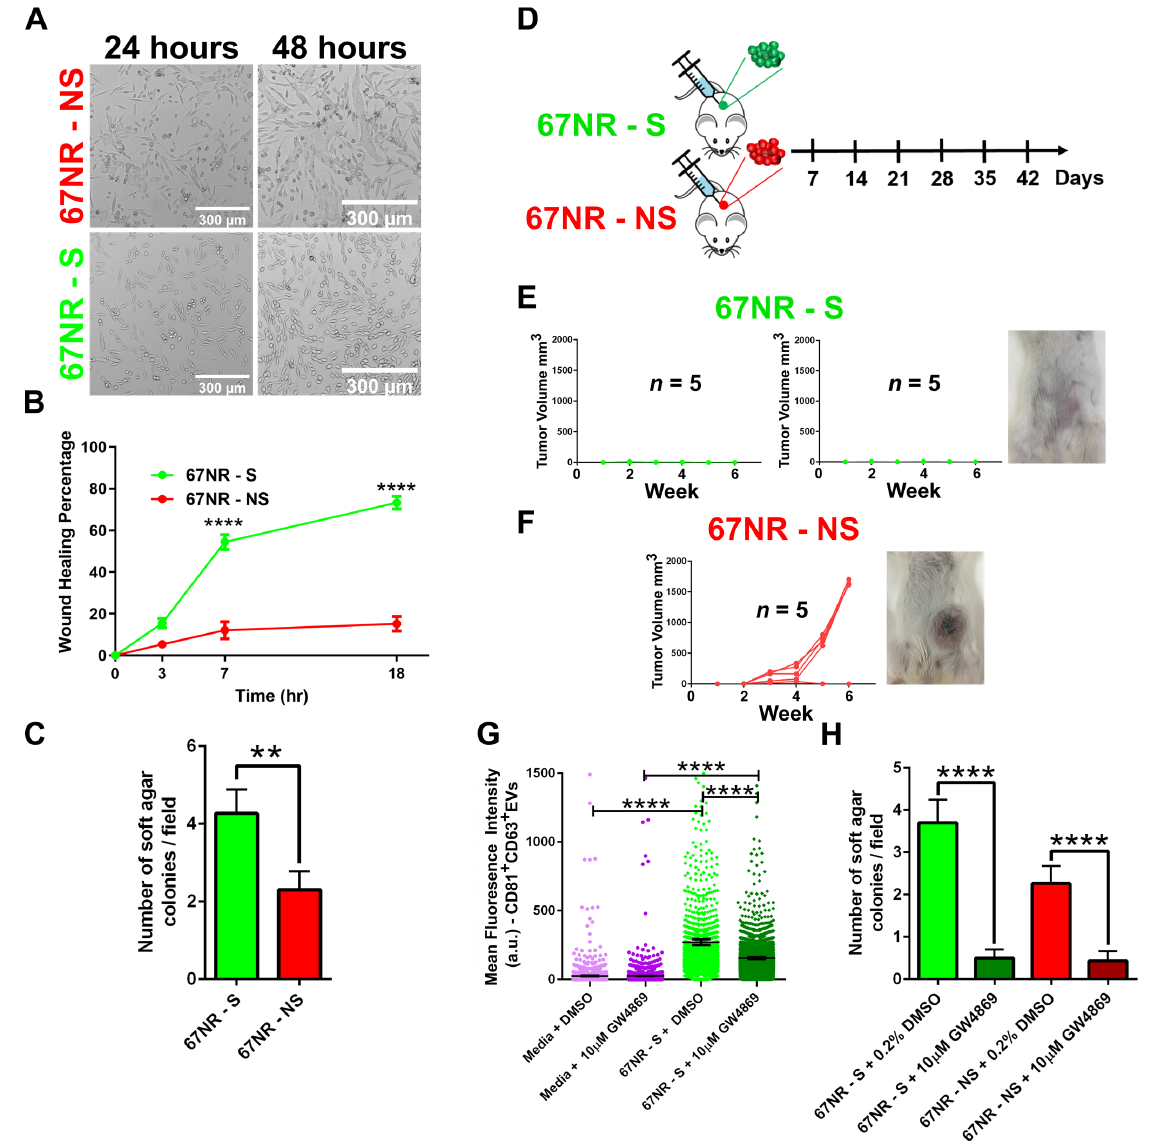
Figure 4. Assessing the functionality of 67NR-NS and 67NR-S cells. ( A ) The morphology of 67NR-NS and 67NR-S cell populations recorded using phase-contrast microscopy. ( B ) Wound healing assays illustrating the migration of 67NR-S and 67-NR-NS clonal cell populations (mean ± SEM, n = 6 for each cell line). Two-way ANOVA was used for comparison; **** p < 0.0001. ( C ) 67NR-S cell populations have a higher capacity to form colonies in comparison with 67NR-NS cell populations (mean ± SEM). The Mann–Whitney t-test was used for comparison; ** p < 0.01. ( D ) The design of mice experiments for comparing the efficacy of tumor formation by 67NR-S and 67NR-NS cell lines. ( E ) Tumor growth monitoring of BALB/c mice injected with 67NR-S clones (two clonal cell populations, five mice each). A representative image of a single mouse is shown. ( F ) Tumor growth monitoring of BALB/c mice injected with 67NR-NS clone (single clonal cell population, five mice). A representative image of a single mouse is shown. ( G ) Inhibition of EV secretion within 67NR-S clonal cell populations by 10 µ M GW4869 compared with DMSO control using a 48 h transwell assay. Media containing either 10 µ M GW4869 or DMSO were used as a negative control. Each dot represents CD63 (EVs) intensity on a single bead (mean ± SEM). The Mann–Whitney t-test was used for comparison; **** p < 0.0001. ( H ) Inhibition of colony formation in 67NR-S and 67NR-NS clonal cell populations upon treatment with 10 µ M GW4869 (mean ± SEM). The Mann–Whitney t-test was used for comparison; **** p <